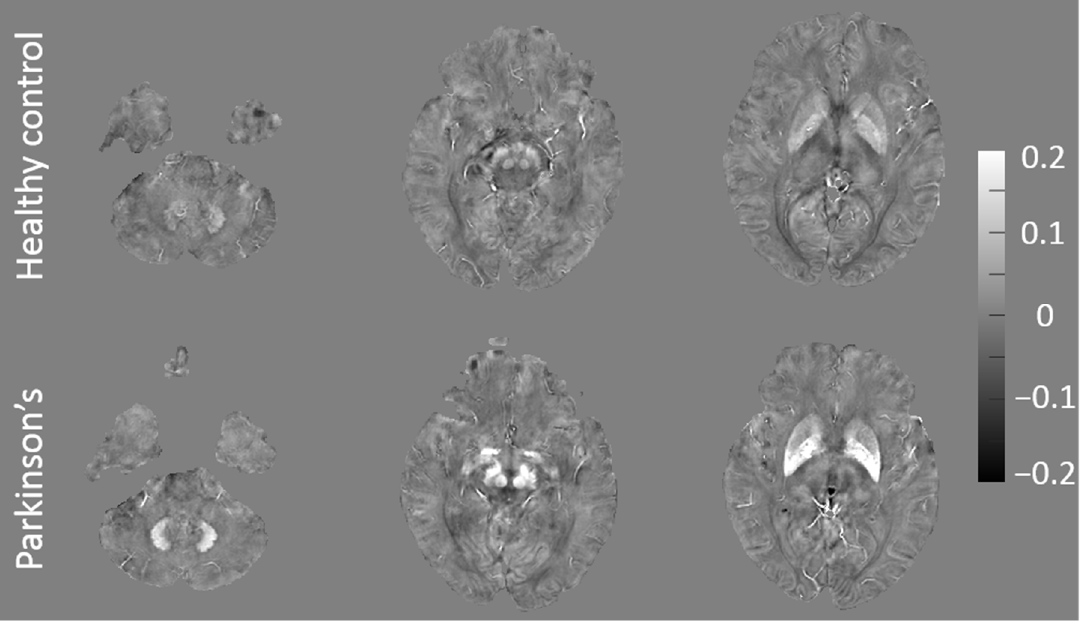
Figure 2. Representative quantitative susceptibly mapping (QSM) images of healthy control and patient with the early stage of Parkinson’s disease. The patient shows brighter signals in basal ganglia areas than the healthy control, demonstrating iron accumulation in the early stage of Parkinson’s disease.